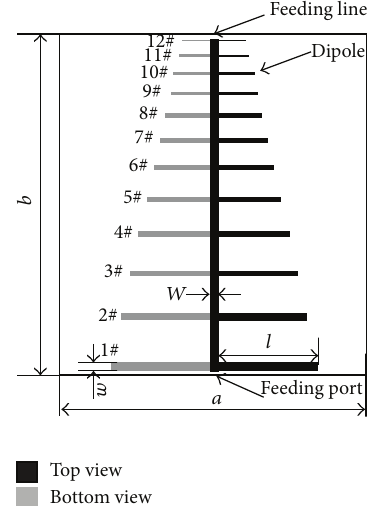
Figure 1: Design of proposed antenna with numbered dipoles of 1–12 from the bottom up.